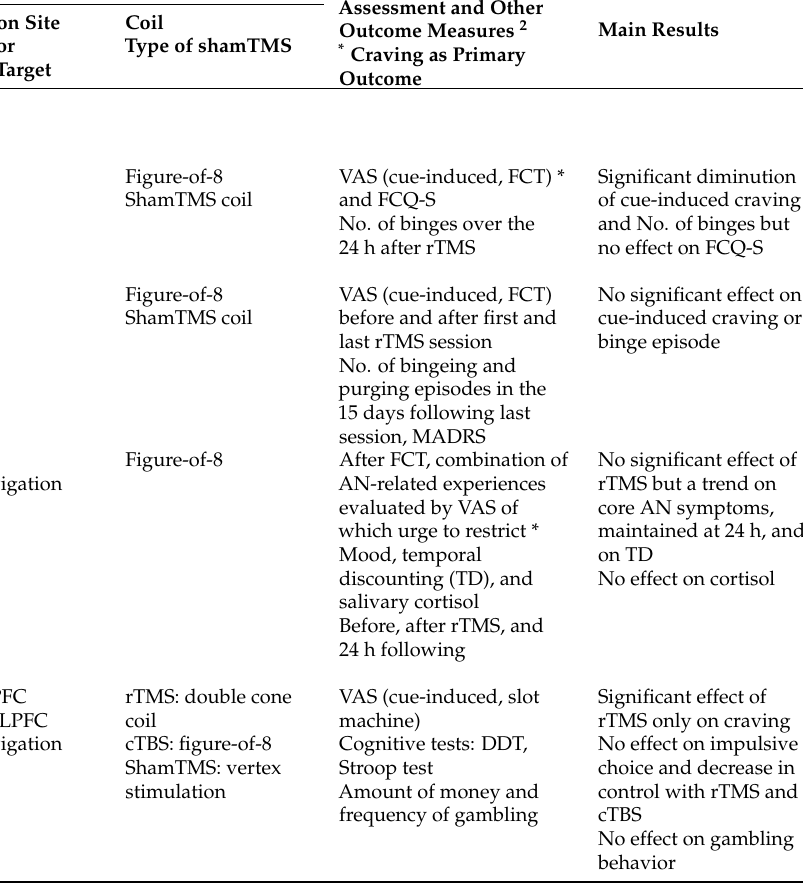
Significant diminution of cue-induced craving and No. of binges but no effect on FCQ-S No significant effect on cue-induced craving or binge episode No significant effect of rTMS but a trend on core AN symptoms, maintained at 24 h, and on TD No effect on cortisol